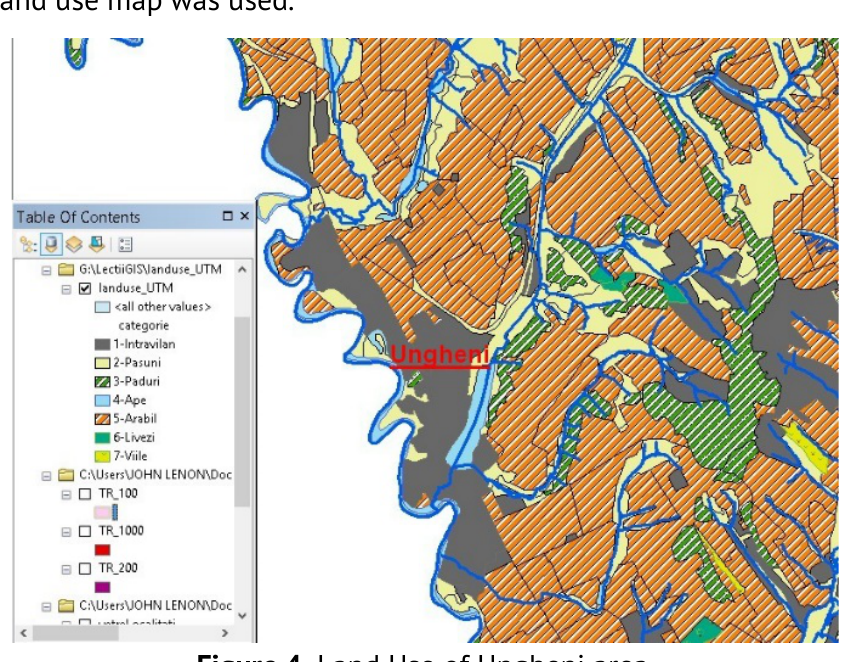
Figure 4. Land Use of Ungheni area. Source: